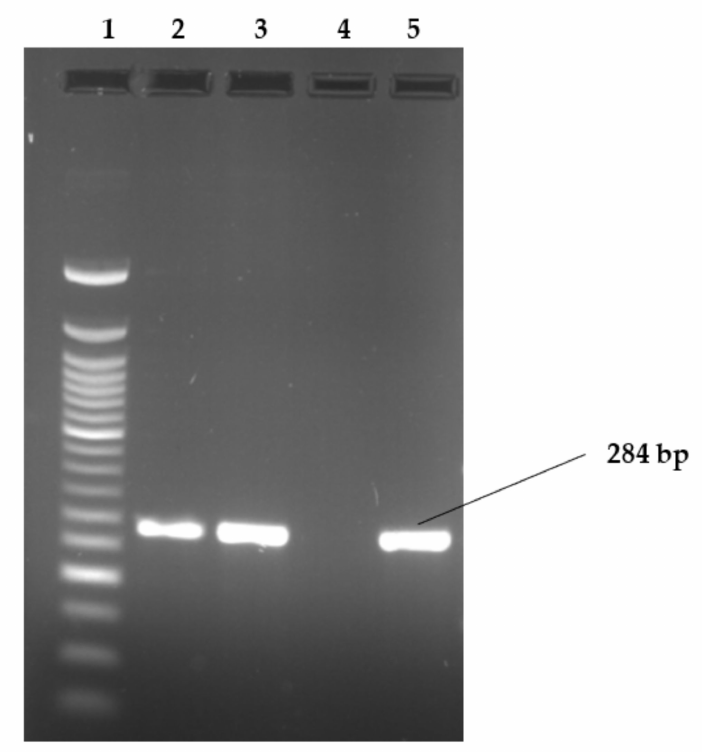
Figure 2. Image showing examples of invA gene amplicons observed on agarose gel.